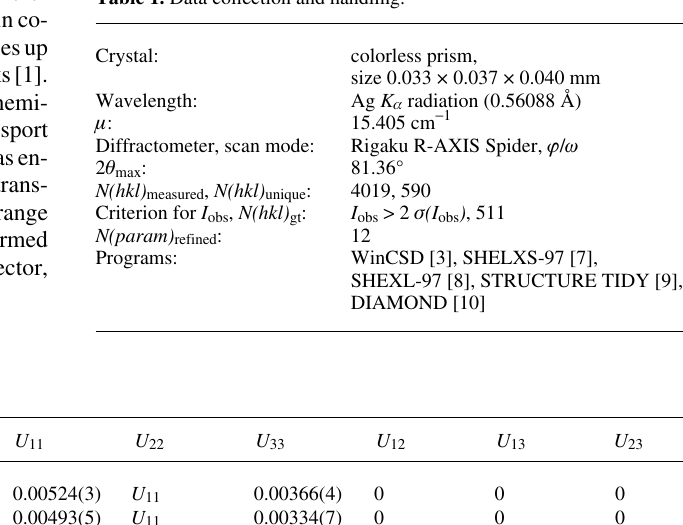
Table 1. Data collection and handling.